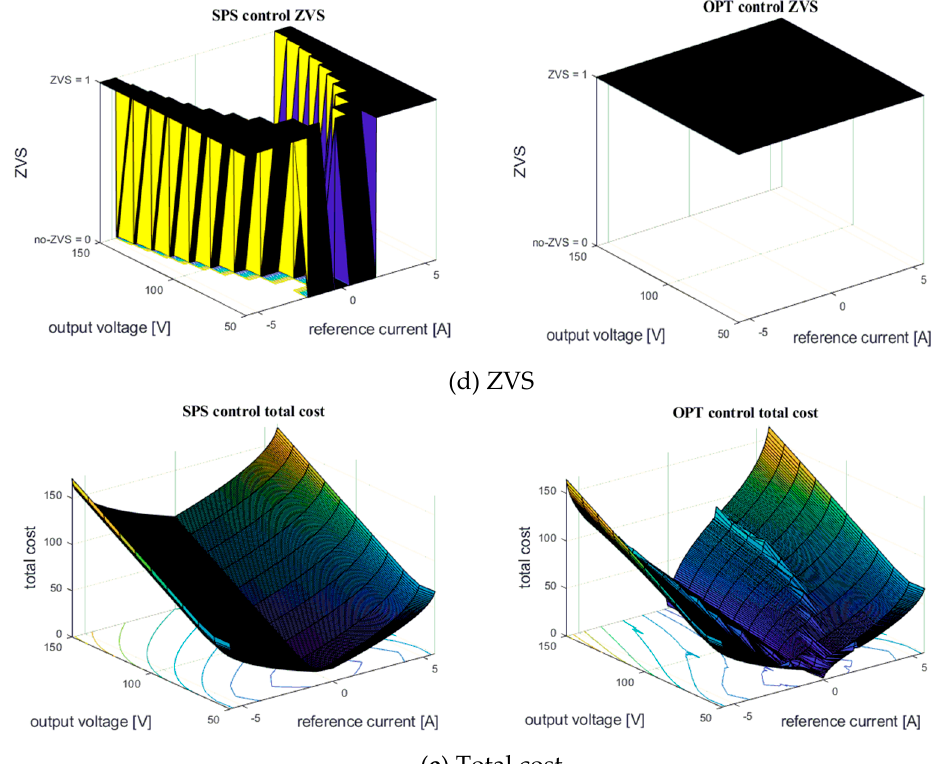
Figure 8. Cost function and its components, 3D surface plots for SPS control and optimized control, with variable voltage.